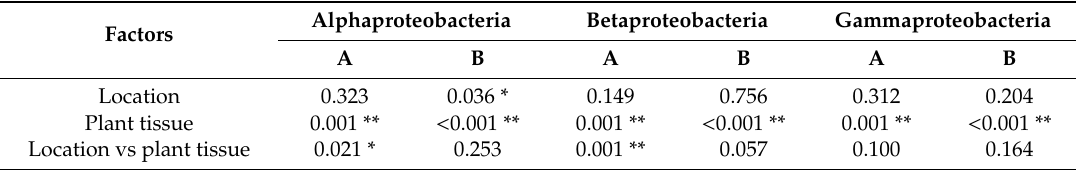
Table 1. Influence of sampling location and tissue on the P. colorata endophytic bacterial communities similarity (A) and richness (B).